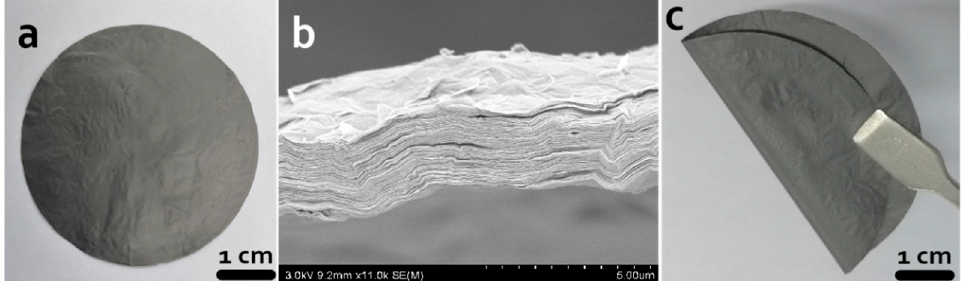
Figure 2. Morphology pictures. ( a , c ) Digital images of the self-supported rGO membrane; ( b ) SEM image of the cross section.